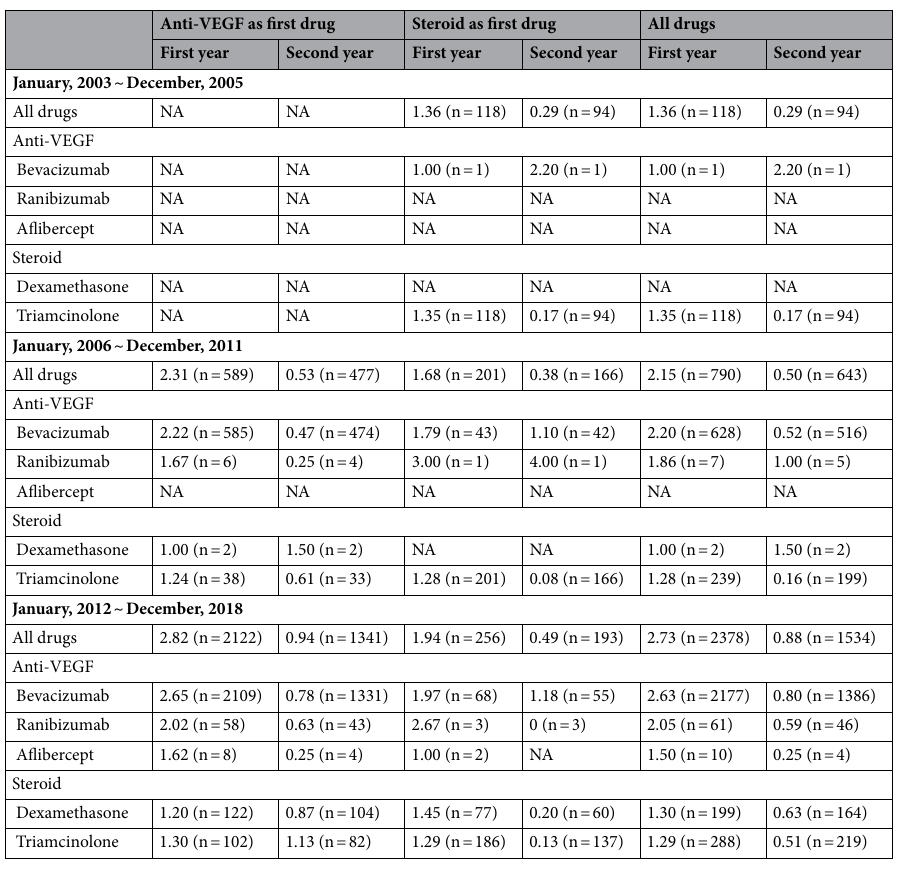
Table 1. Average number of intravitreal injections in all treated patients with macular edema following retinal vein occlusion. VEGF, vascular endothelial growth